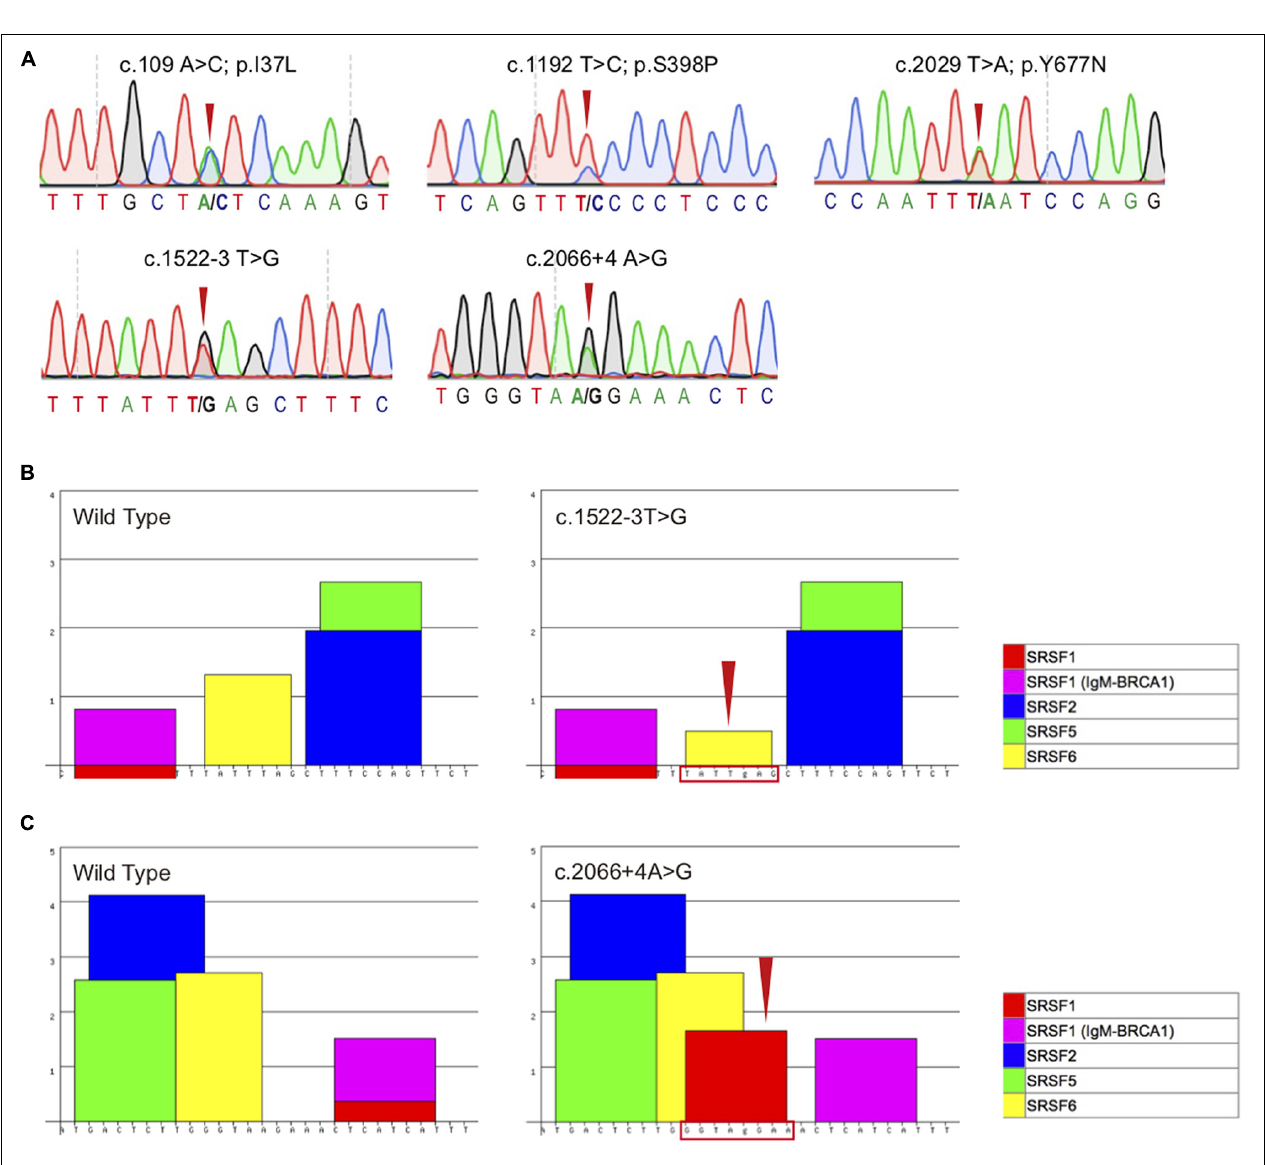
FIGURE 1 | corresponding to the former splicing modes; red lines indicate positions of premature stop codon. (D) Left: agarose gel electrophoresis of RT-PCR products, lane 1: cDNA from HEK293T cells (blank control), lane 2: cDNA from W-minigene 2 plasmid (wild type control, bearing TBK1 c.2066 + 4A), lane 3: cDNA from V-minigene 2 plasmid ( TBK1 c.2066 + 4A > G variant). Middle: schematic of normal splicing mode (WT) and aberrant splicing mode (MUT) of V-minigene 2 plasmid; green lines show normal splicing modes, red lines show aberrant splicing modes, yellow boxes indicate exons, gray boxes indicate introns, E17: exon 17, E18: exon 18, E19: exon 19, E20: exon 20. Right: T-A clone results of RT-PCR products from V-minigene 2 plasmid and schematic of TBK1 protein corresponding to the MUT splicing mode. (E) RNA pull-down assay and western blot analysis. Synthetic RNAs were labeled with biotin and incubated with nuclear extract from HeLa cells, then the RNA-binding protein complexes were interacted with anti-hnRNPA1 antibody specifically and separated by SDS-PAGE. (F,G) Immunofluorescence analysis of subcellular distribution of TBK1 in HEK293T cells overexpressed by TBK1 cDNA carrying c.1522-3T or c.1522-3G (F) and TBK1 cDNA carrying c.2066 + 4A or c.2066 + 4G (G) was visualized by anti-FLAG antibody followed by anti-mouse Alexa Fluor 594 (red)-conjugated secondary antibody and DAPI (blue) staining. Scale bar: 50 µ m.